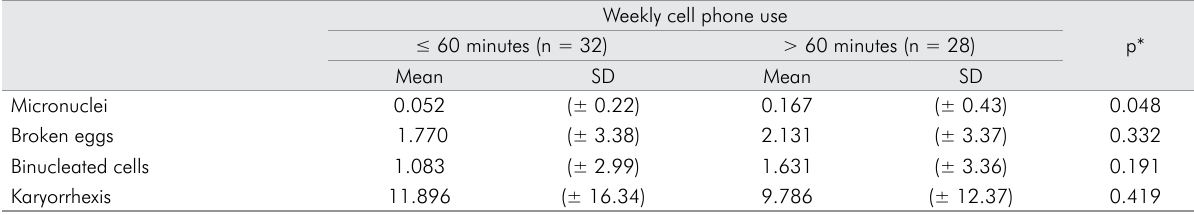
Table 2. Comparison of weekly cell phone use and mean values of nuclear changes within the whole oral mucosa (3,000 cells). Weekly cell phone use